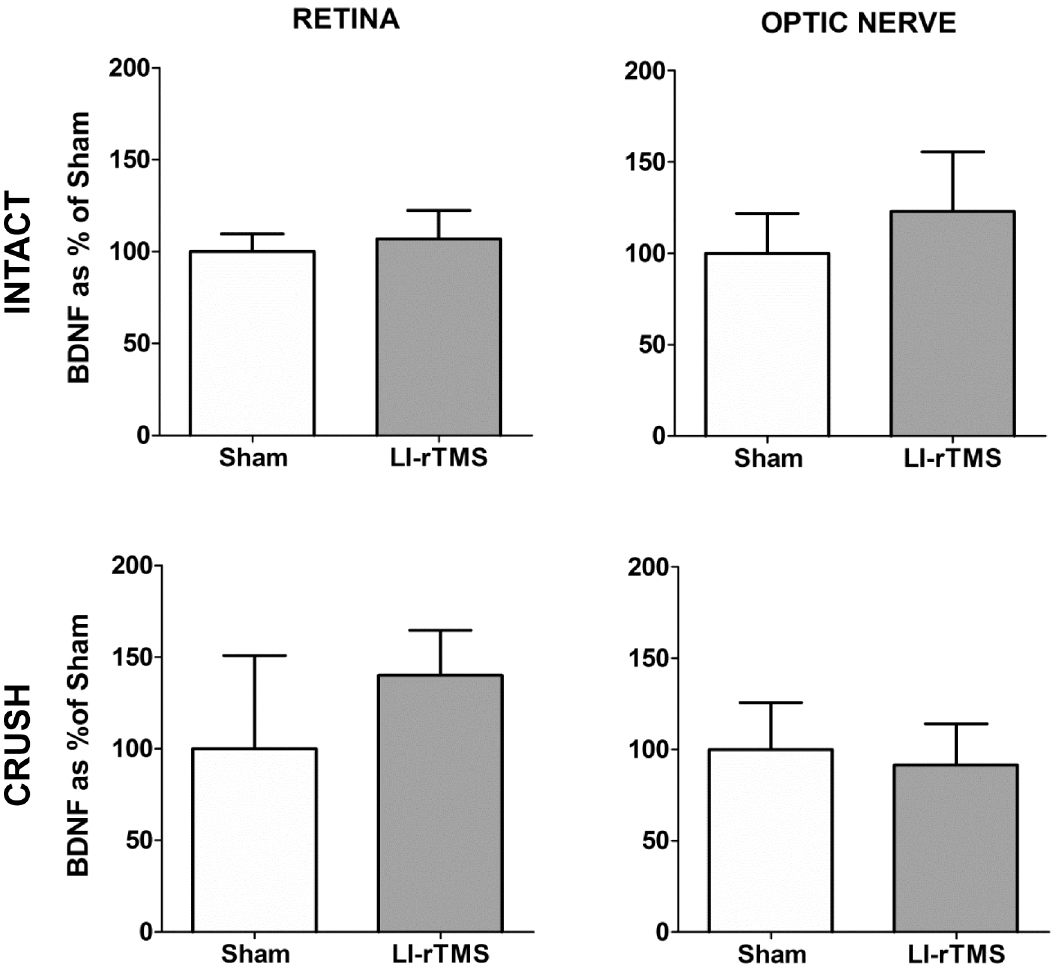
Fig 3. BDNF ELISA data. Daily LI-rTMS for 1 week does not increase BDNF levels in the retina or optic nerve of optic nerve crush or intact mice (p > 0.05 for all groups; see results section). Histograms show BDNF levels as % of sham stimulated group. Error bars are standard error of the mean.